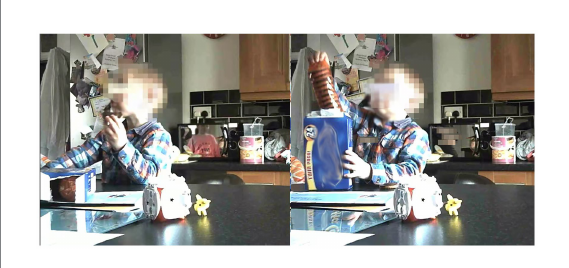
FIGURE 10 An example of a child serving themselves (MU04S2:49 m).